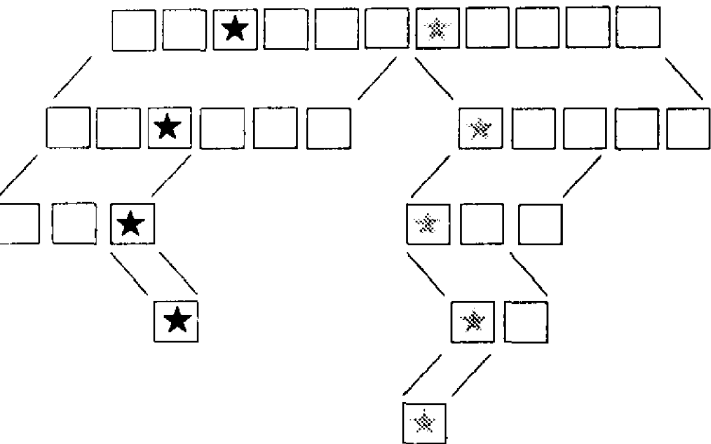
Figure 5. Quine’s Binary Tree (reprinted from